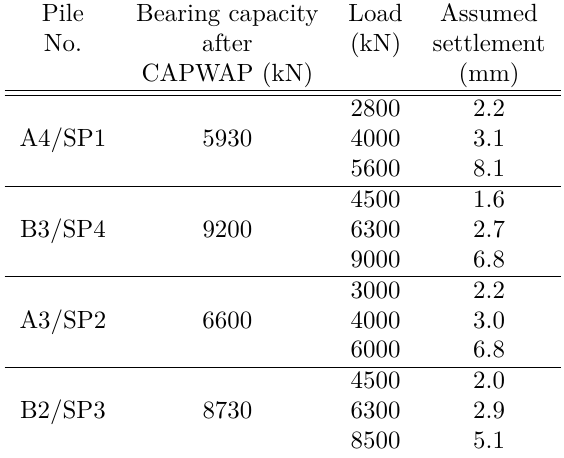
Table 3. Assumed settlement from static